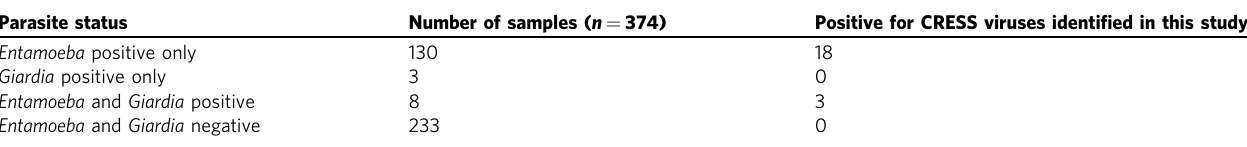
Table 1 Entamoeba and Giardia status of human samples positive for any of the CRESS viruses identi fi ed in this